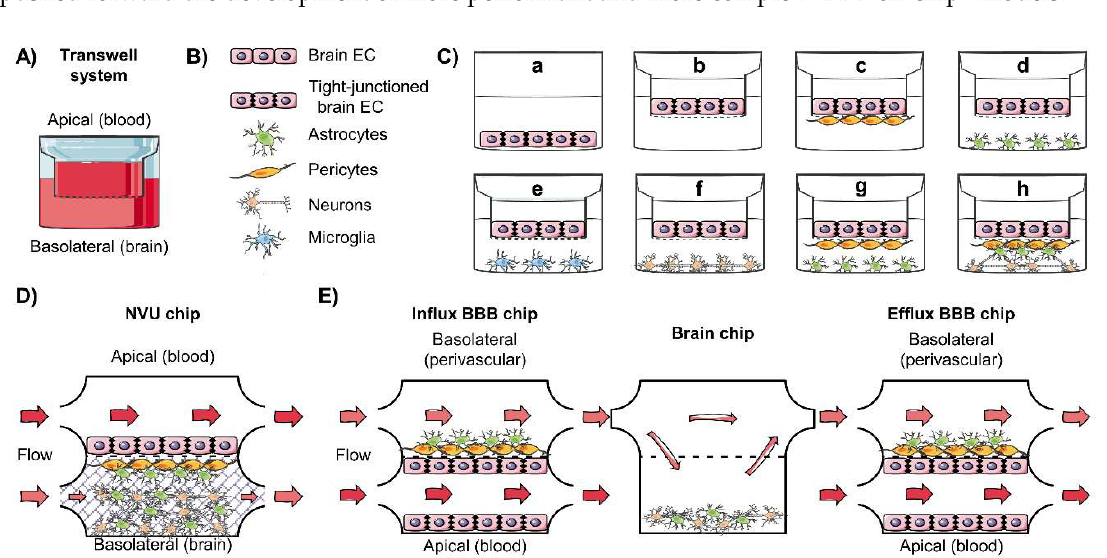
Figure 3. Schemas of examples of in vitro models of the blood–brain barrier (BBB) . ( A ) Cells conforming the neurovascular unit (NVU) used for cell culture, usually in ( B ) Transwell systems with an apical (blood) and basolateral (brain) space, separated by a permeable membrane (dashed line). ( C ) Primary or cell lines of brain endothelial cells (EC) can be cultured ( a ) directly in wells to study drug absorption or ( b ) in transwells for permeability assays; ( c to f ) cocultures with other cells from the NVU can improve the BBB phenotype, including the tight junctions (black rhombus (cid:7) ); ( g and h ). Furthermore, a